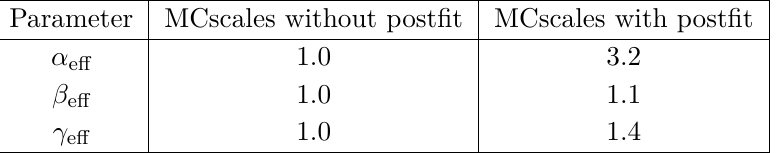
Table 7 . Estimates of the effective model parameters before and after applying postfit vetoes, where for β eff and γ eff the values are averaged over processes.